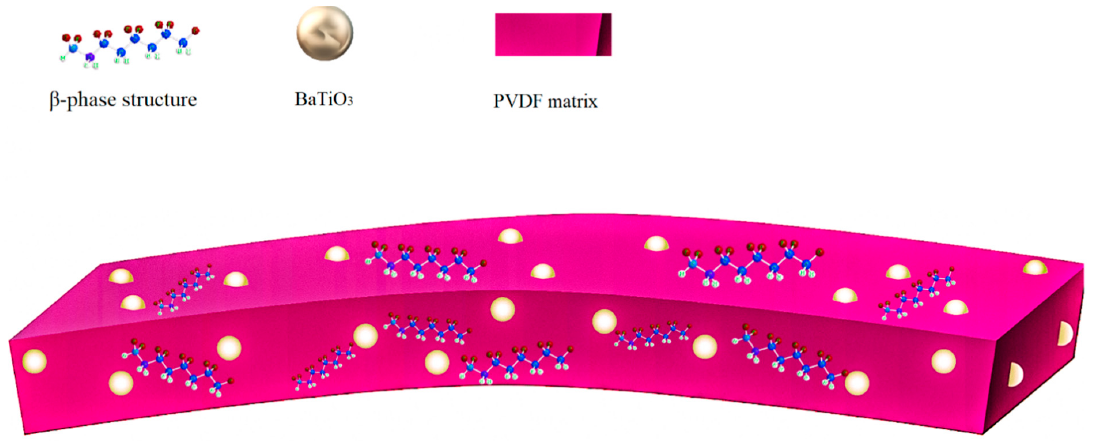
Figure 5. Schematic of the nucleating effect of BaTiO 3 nanoparticles in PVDF.